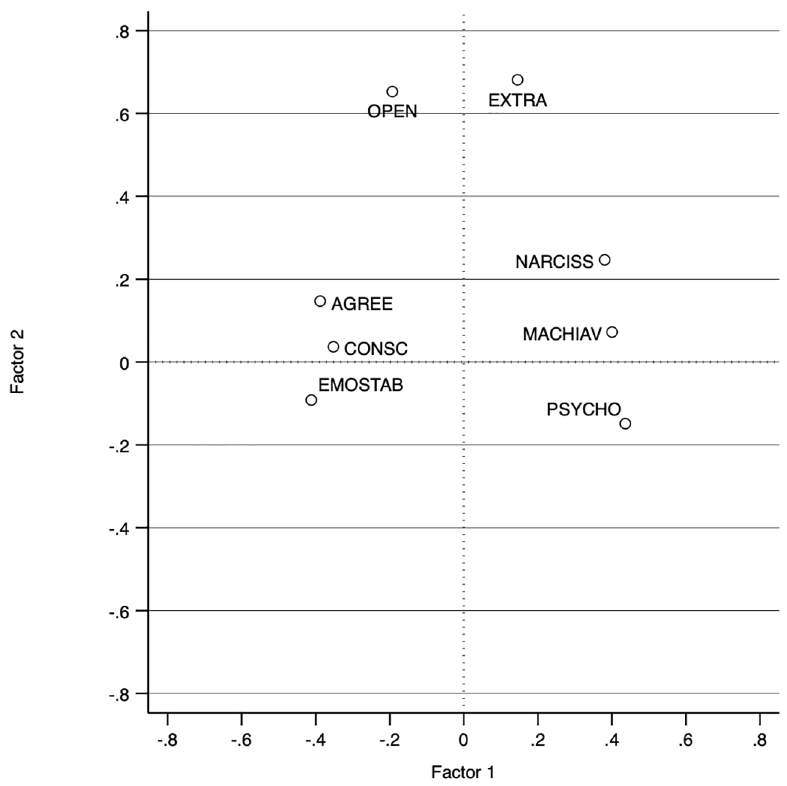
Figure 1. Second-order factors of personality (PCA). Note. N = 122. Full results of the PCA are available in Table B13 in the Appendix (see Supplementary